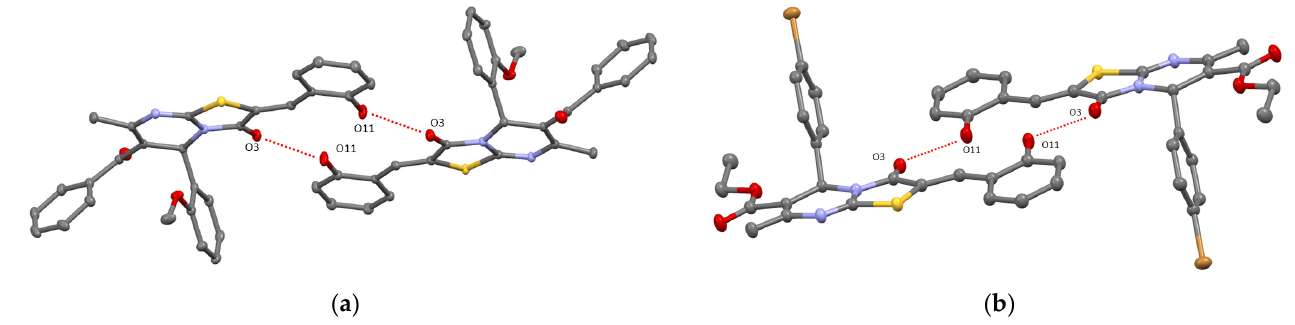
Figure 3. ORTEP ‐ view of supramolecular dimers resulting from intermolecular H ‐ bonding in crystals of compound 11 ( a ) and 12 ( b ). The ellipsoids are presented with 50% probability, H ‐ atoms are omitted for clarity. H ‐ bonding is presented by red dotted lines.